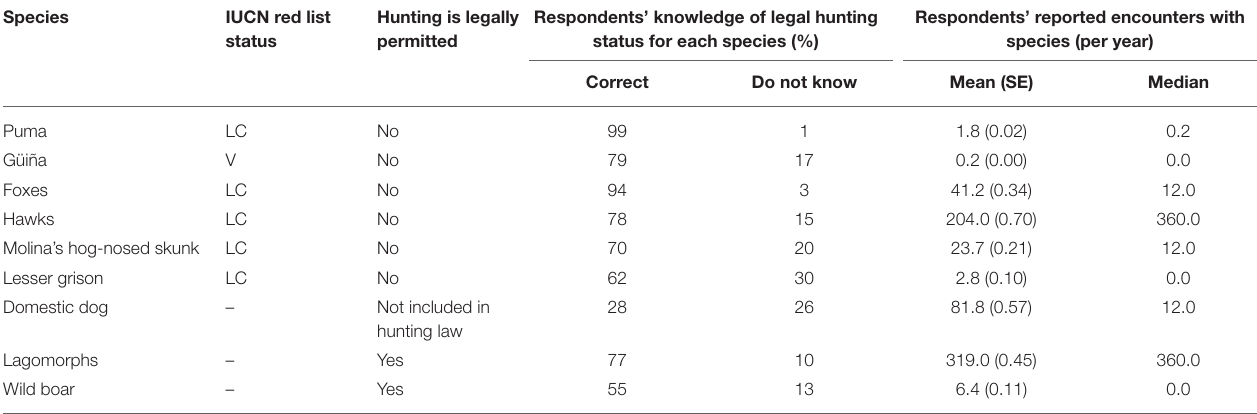
TABLE 2 | Questionnaire respondents’ ( N = 233) knowledge of how the hunting law in Chile relates to each of the predators in our study, and the frequency of encounters they have with each species on their property or surroundings.